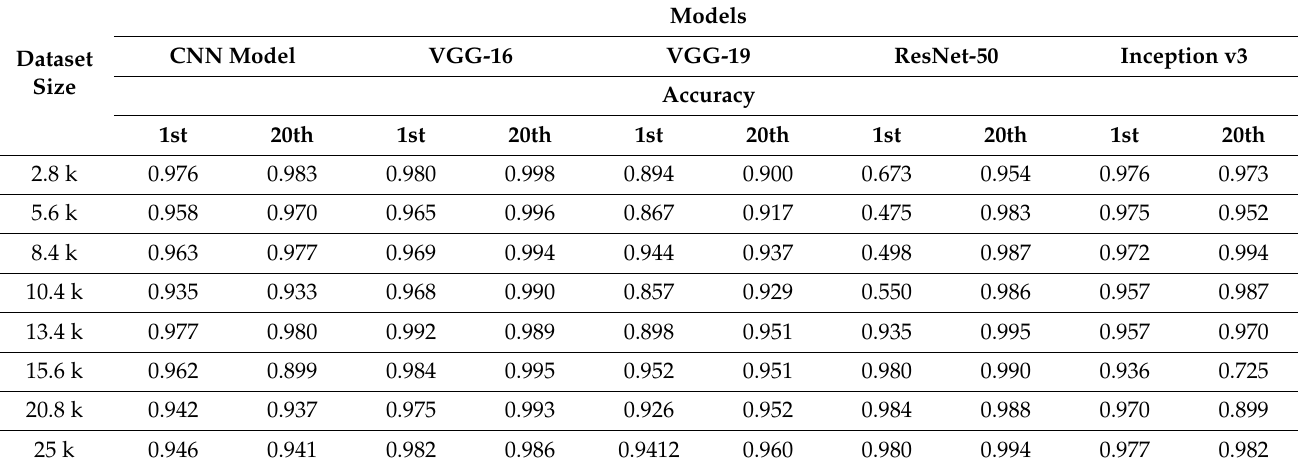
Table 4. Accuracy of the models at the 1st and 20th